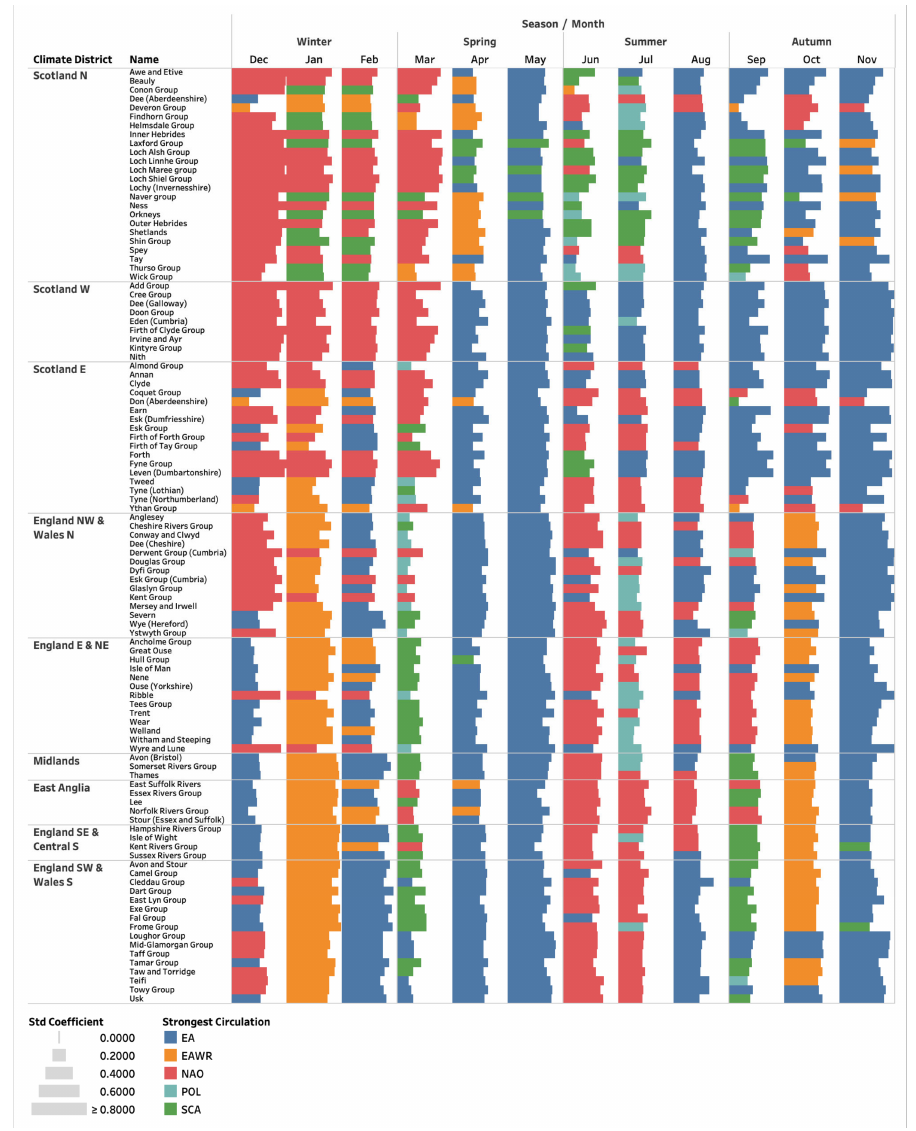
Figure 10. The strongest standardised coefficient values from Figures 5–9. Colour indicates which circulation is the most influential in the multivariate regression (i.e., the circulation with the strongest absolute SC value). The size of the bar is based on the absolute SC